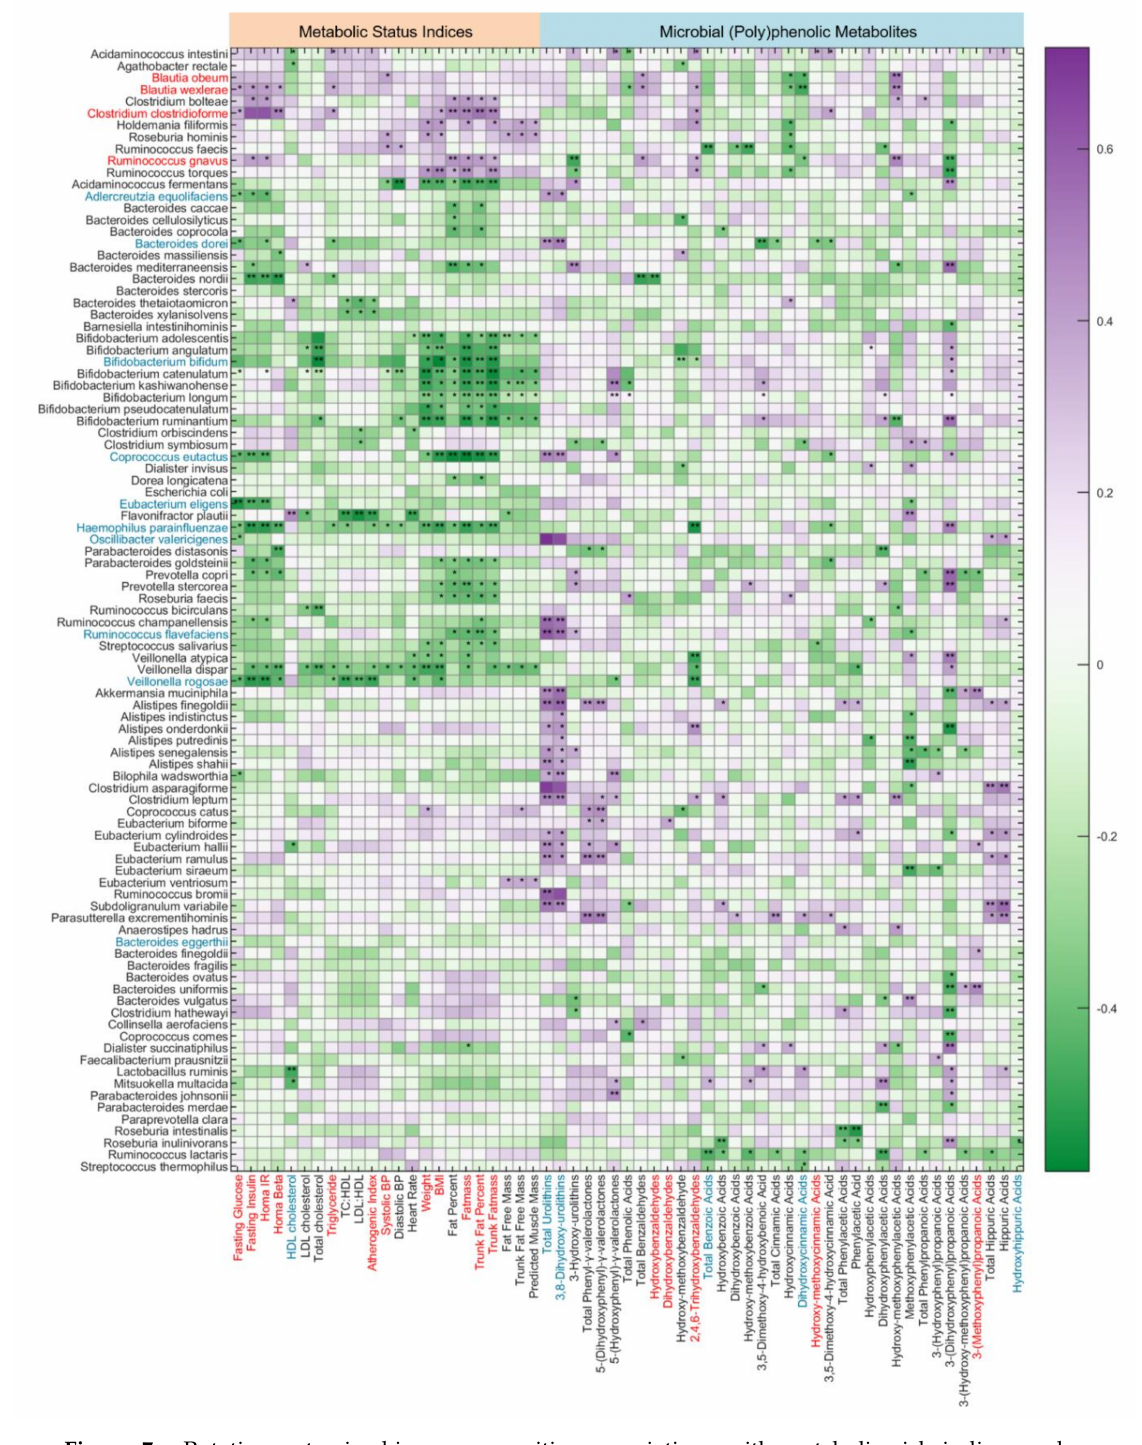
Figure 7. Putative gut microbiome composition associations with metabolic risk indices and microbial (poly)phenolic metabolites. Biomarkers with statistically significant correlation in the PreDM-IR and the Reference groups are colored red and blue, respectively. Heatmap color intensity represents the magnitude of correlation. Purple = positive correlations; green = negative correlations. Significant correlation, * p < 0.05 and ** p <